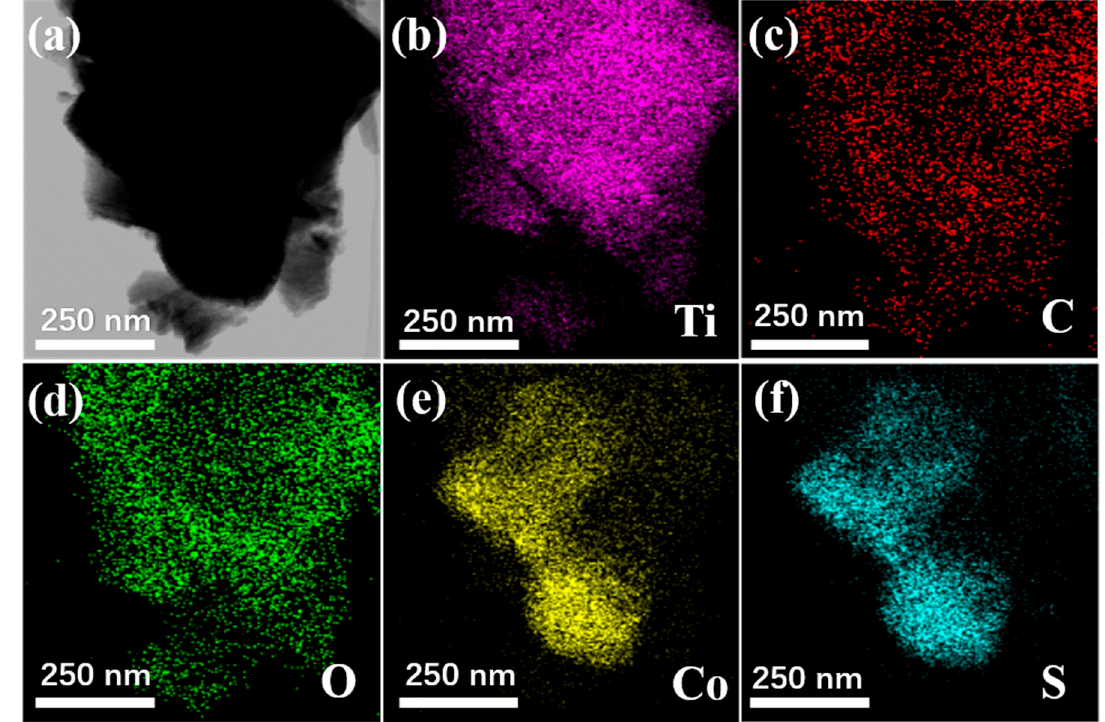
Figure 5. TEM of CoS@Ti 3 C 2 T x ( a ), and its corresponding elemental mapping images of Ti ( b ), C ( c ), O ( d ), Co ( e ), and S ( f ).